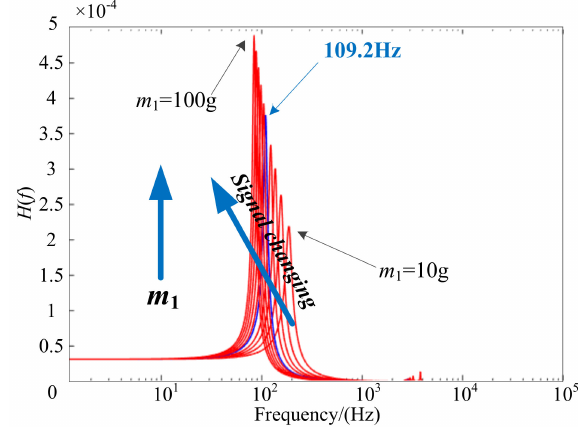
Figure 3. Effects of m 1 on the frequency response of the plastic box.